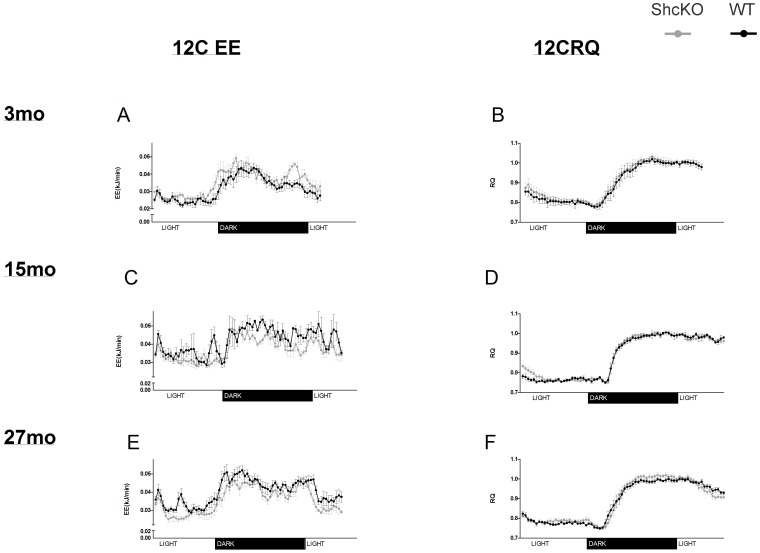

Energy expenditure (EE) and respiratory quotient (RQ) in ShcKO and wild-type (WT) mice housed at 12°C. Mean (±SEM) EE and RQ values collected over a 24 hour period in 3 mo (A&B), 15 mo (C&D), and 27 mo (E&F) mice. ShcKO = p66 Shc(−/−) mice, mo = months.